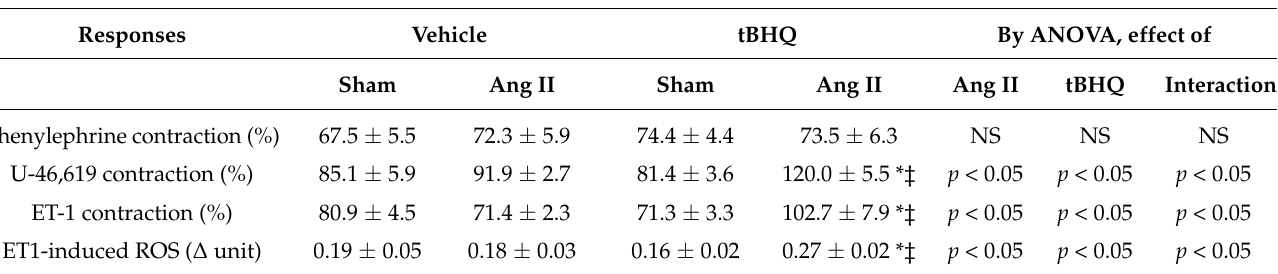
Table 3. Maximum contractions to phenylephrine, thromboxane (U-46,619) and endothelin 1 and ROS generation with endothelin 1 in mesenteric microarterioles: effects of tert-butylhydroquinone (tBHQ) administration and angiotensin II infusion (Ang II; Panel A) for three days, of tBHQ administration to Nrf2 +/+ (vs. − / − ) mice infused with Ang II for three days (Panel B) and of cyclooxygenase 1 − / − (vs. +/+) with blockade of cyclooxygenase 2 with parecoxib (vs. vehicle) in mice given tBHQ and infused with angiotensin II for 3 days (Panel